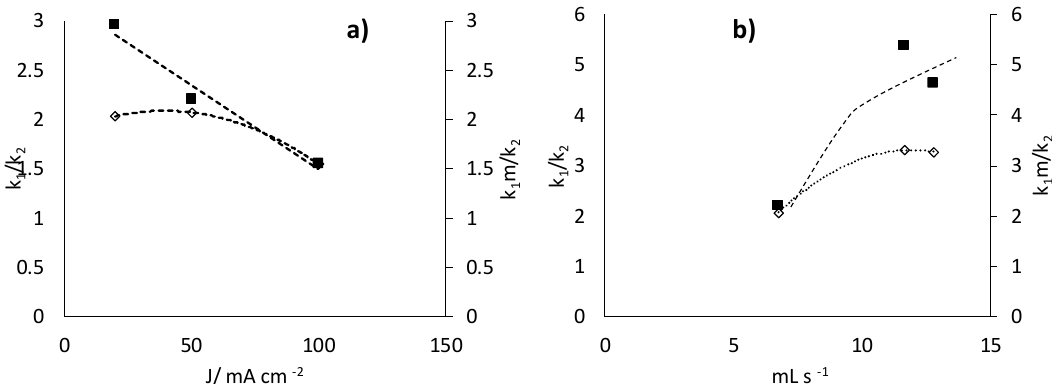
Figure 6. Comparison of the oxidazability of 17 β -estradiol and uric acid by showing the trends of the ratios k 1 /k 2 ( ■ ) and k 1m /k 2 ( ◊ ) as function of current density ( a ) and flowrate ( b ).